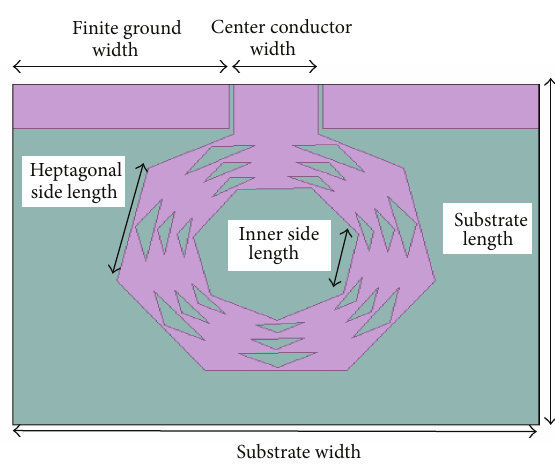
Figure 2: Monopole fractal antenna structure.